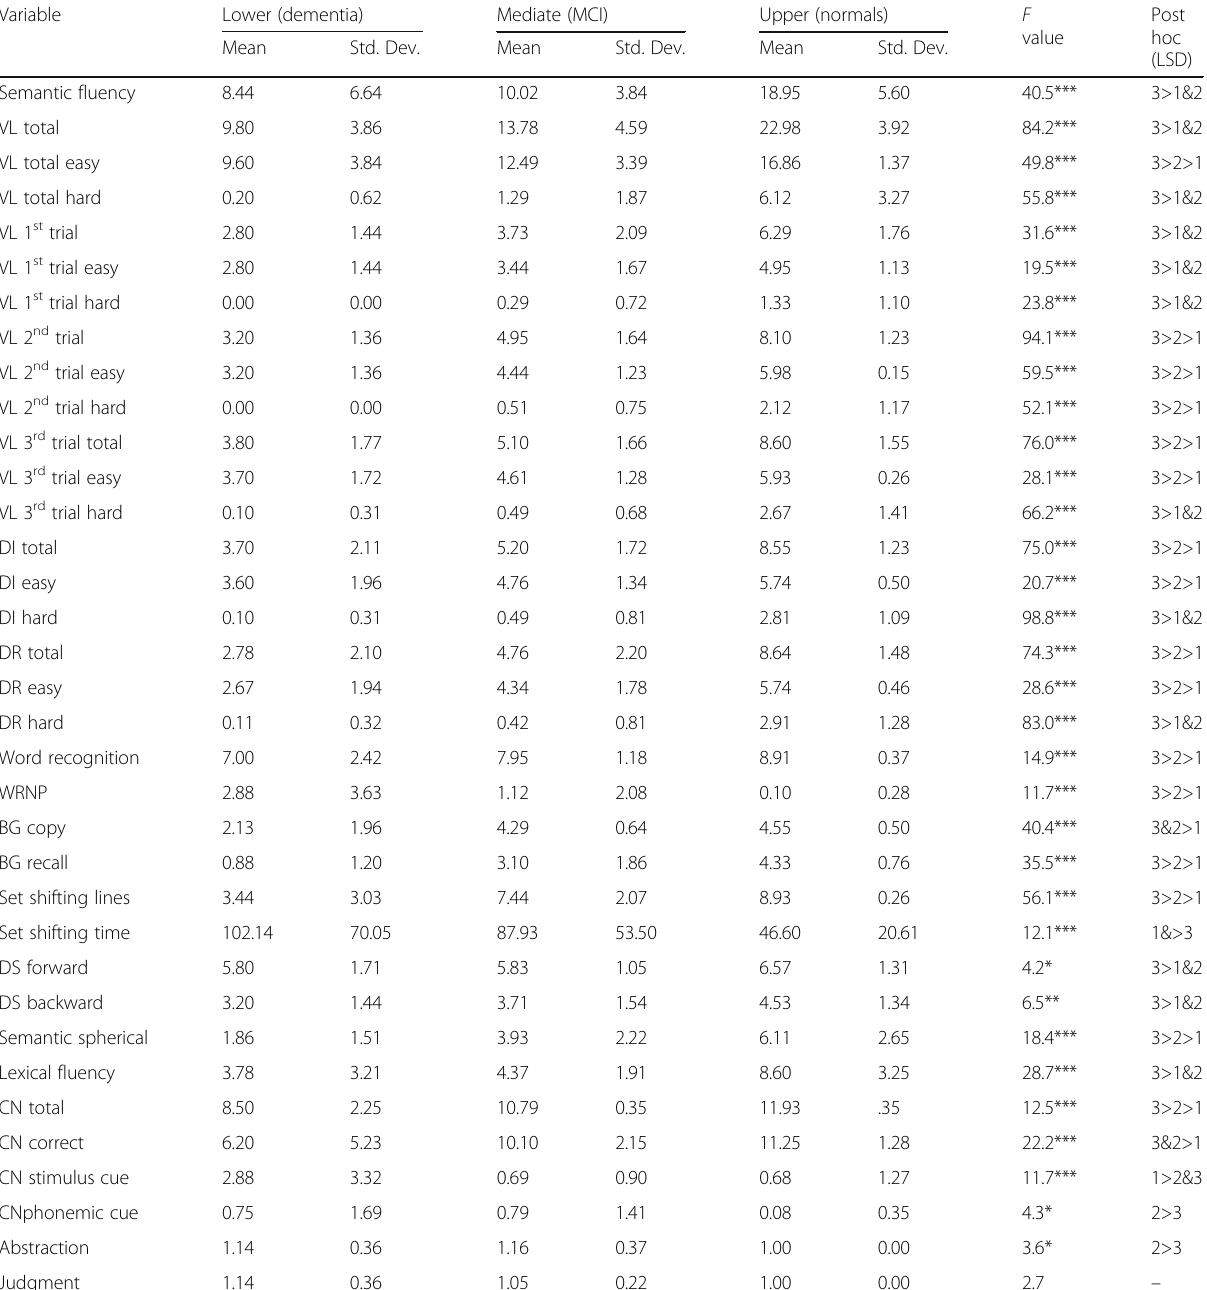
Table 4 Significant F test for between groups accordingly to three quadrants of MMSE within educated ( N = 106) Variable Lower